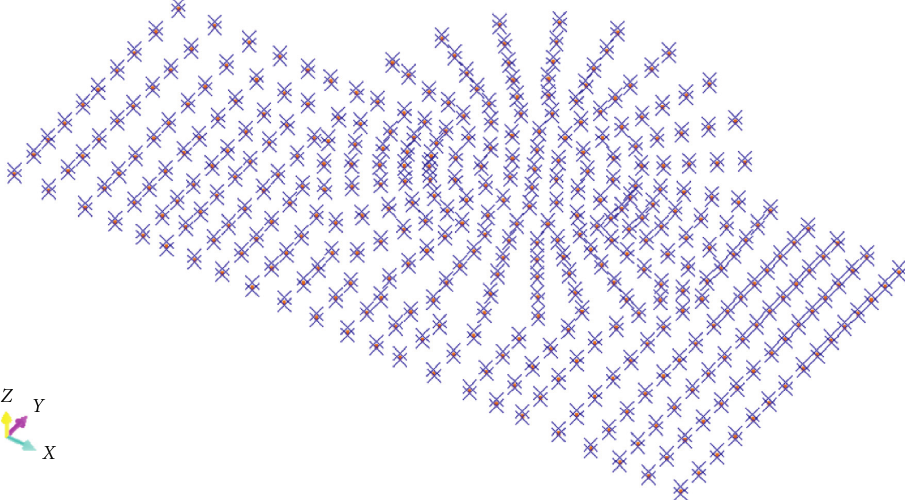
Figure 3: The arrangement of isolation bearings.